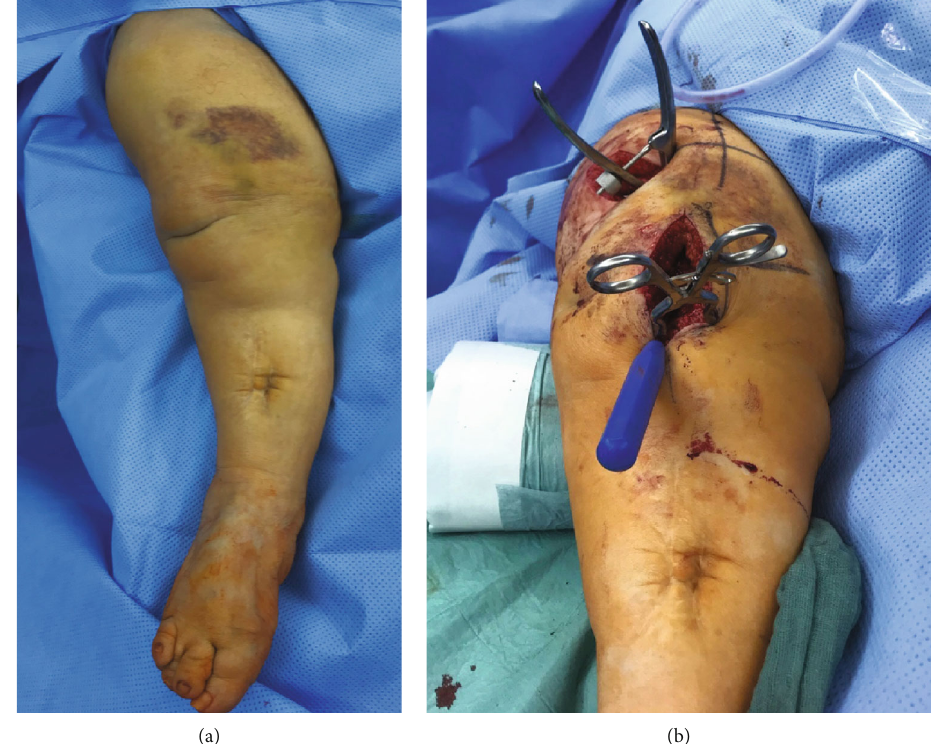
Figure 2: Clinical picture of the fractured femur in the operating room (a). Intraoperative picture of the situs after repositioning of the fracture (b).